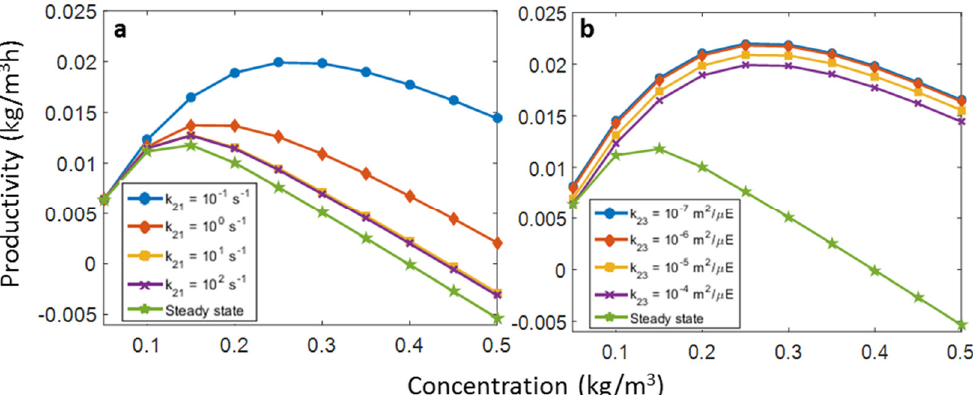
Figure 10. Effect of growth model parameters on biomass productivity of the PBR, depending on microalgal concentration, for Alternate Design A: ( a ) varying k 21 at k 23 = 10 −4 m 2 /μE; ( b ) varying k 23 at k 21 = 0.1 s −1 . Air inlet flowrate was 0.5 L/min and incident light intensity was 1000 μE/m 2 s.